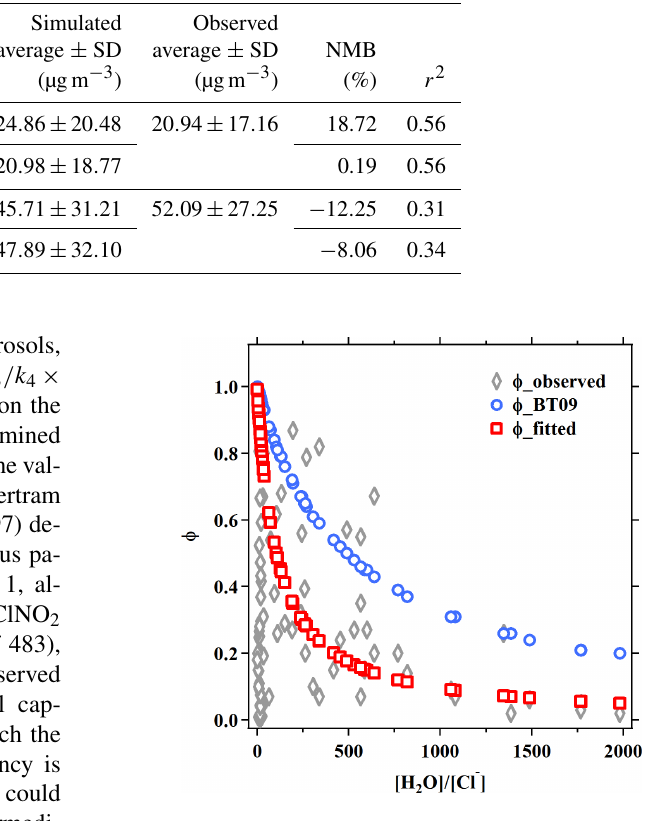
, and the 2 , values from BT09 2